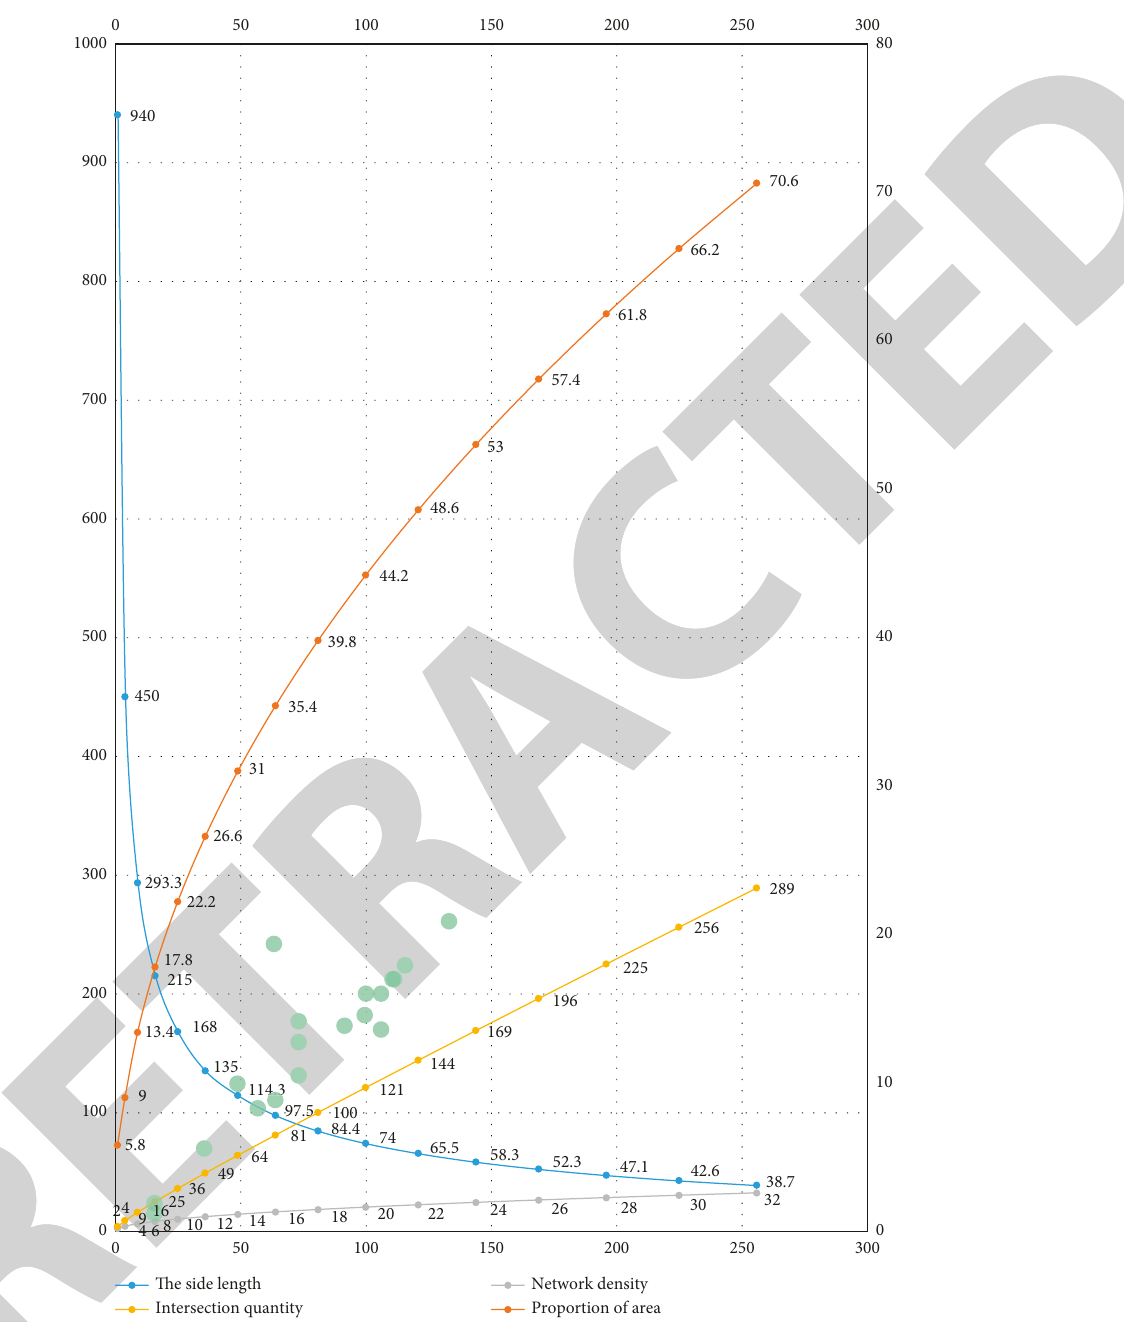
Figure 7: Simulation data of the square block